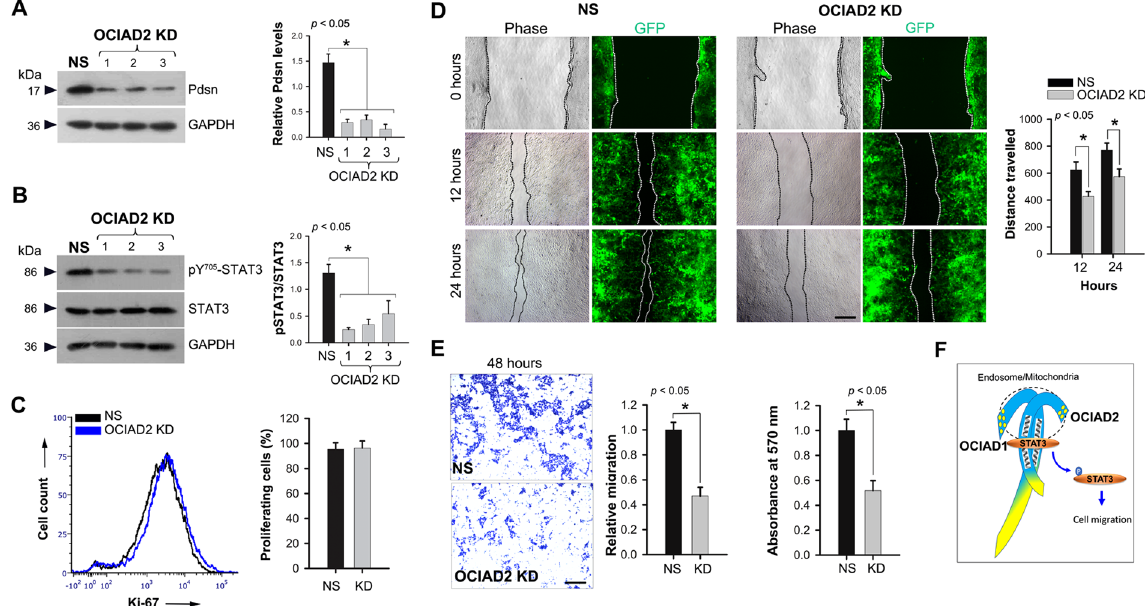
Figure 7. Knockdown of OCIAD2 retards migration of HEK293 cells. ( A ) Western Blotting confirming ociad2 knockdown (KD) in OCIAD2_ shRNA (1, 2 and 3) transfected HEK293 cells as compared to non-silencing (NS) shRNA. Graph shows relative OCIAD2 levels in NS and KD. n = 4 ( B ) Western Blotting for detection of STAT3 and pSTAT3 (Y705) levels in NS and KD. Data are representative of three independent experiments and graph shows relative STAT3/pSTAT3 ratio upon ociad2 KD. Protein size markers (in kDa) are indicated to the left. Full-length blots are presented in Supplementary Figure S6. n = 4 ( C ) Flow cytometry analysis of Ki-67 + population in ociad2 KD HEK293 cells. Graph shows results obtained from four independent experiments (mean ± SEM). ( D ) Reduced migration of ociad2 KD cells observed in wound healing assays. Monolayers of control and ociad2 knockdown HEK293 cells were wounded and the degree of recovery was measured at 0, 12 and 24 hours post-wounding. Representative phase and fluorescence images, 4 × magnification. Measurement and estimation of wound recovery was based on the initial wound size. Graph shows quantification of results obtained from three independent experiments (mean ± SEM) with at least 5 fields analyzed per sample per experiment. ( E ) Representative images (4 × magnification) showing reduced migration of ociad2 KD HEK293 cells after 48 hours in a trans-well migration assays. Graphs represent quantification of cell migration (absorbance at 570 nm) obtained from two independent trans-well experiments performed in two technical replicates (mean ± SEM). * p < 0.05 was used to indicate a statistically significant difference. ( F ) Proposed model depicting the location of OCIAD1 and OCIAD2 and their interaction via the double helical motif (wavy grey lines). Blue shading: conserved region; Yellow: non-conserved regions. STAT3 interaction with OCIAD1 or OCIAD2 (individually or together) leads to STAT3 activation essential for cell